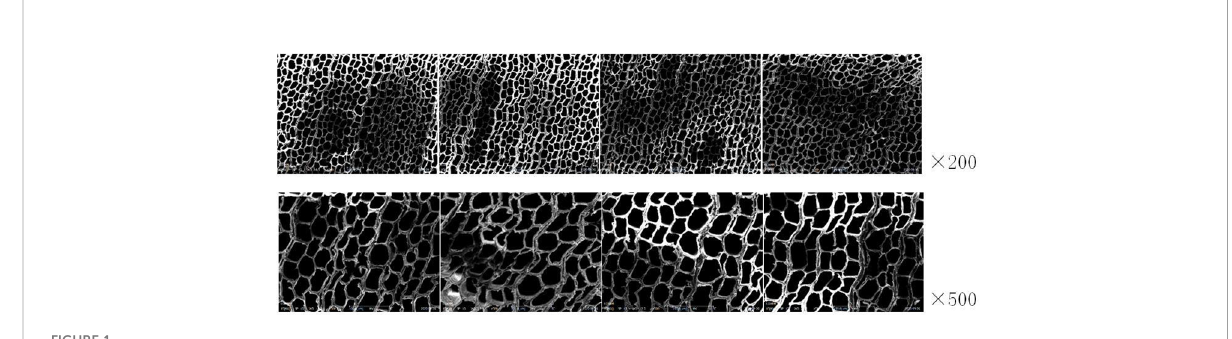
FIGURE 1 Microscopic images of experimental specimens.